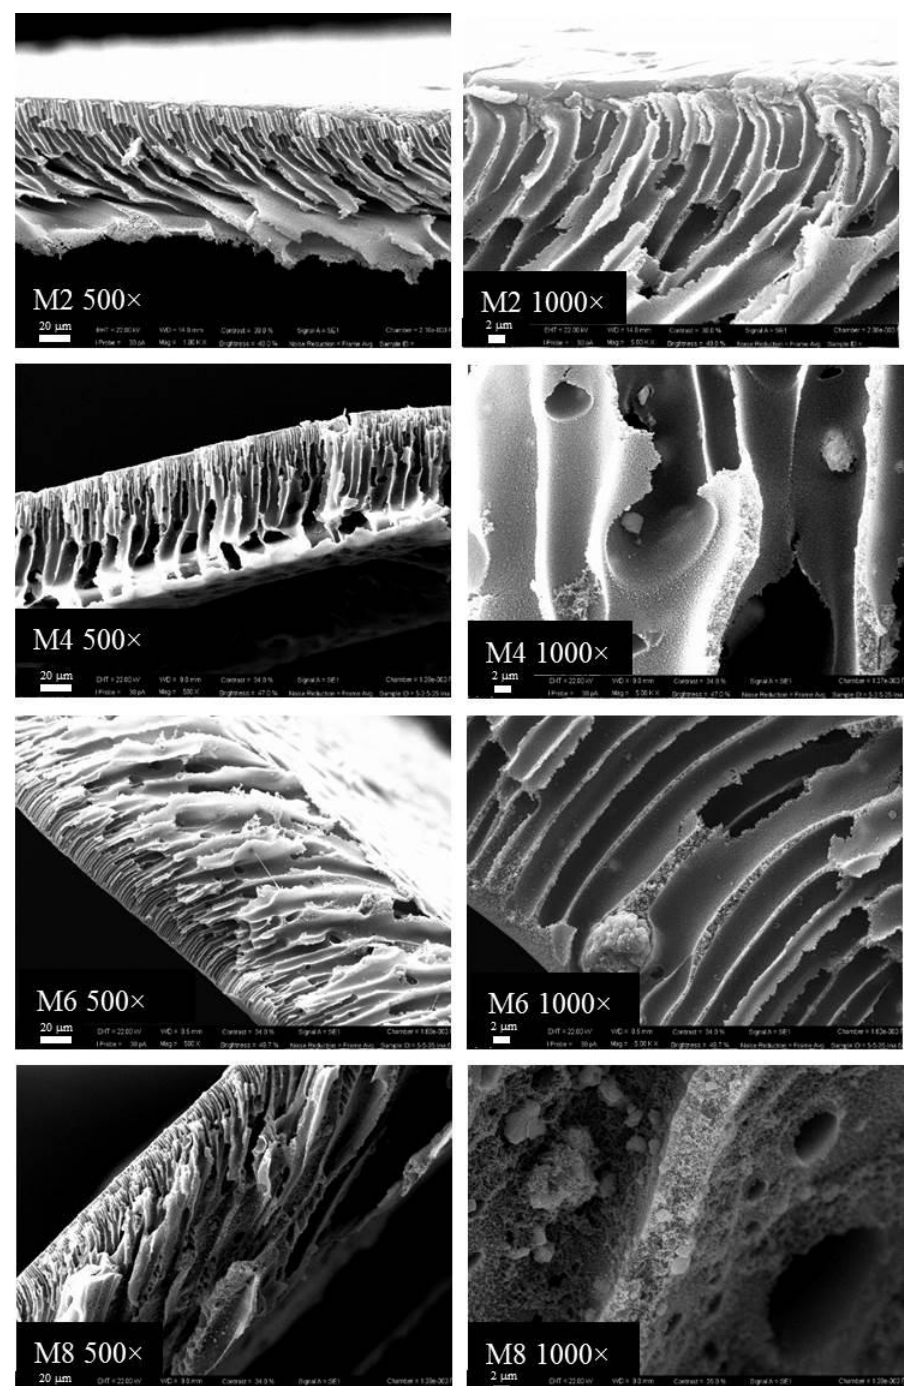
Figure 3. SEM images of the PES and PES–kaolin membranes prepared via NIPS–Vapour Induced Phase Separation (VIPS) procedure.